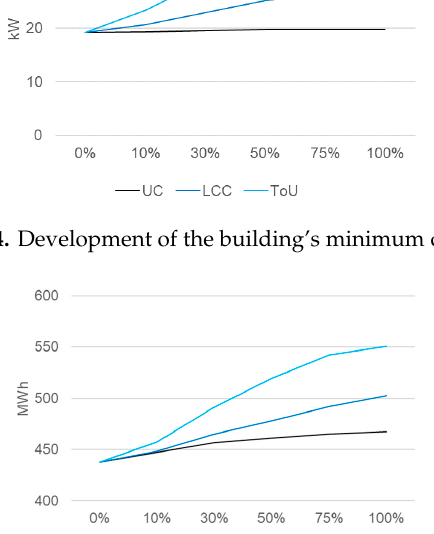
Figure 15. Development of the building’s base volume demand.